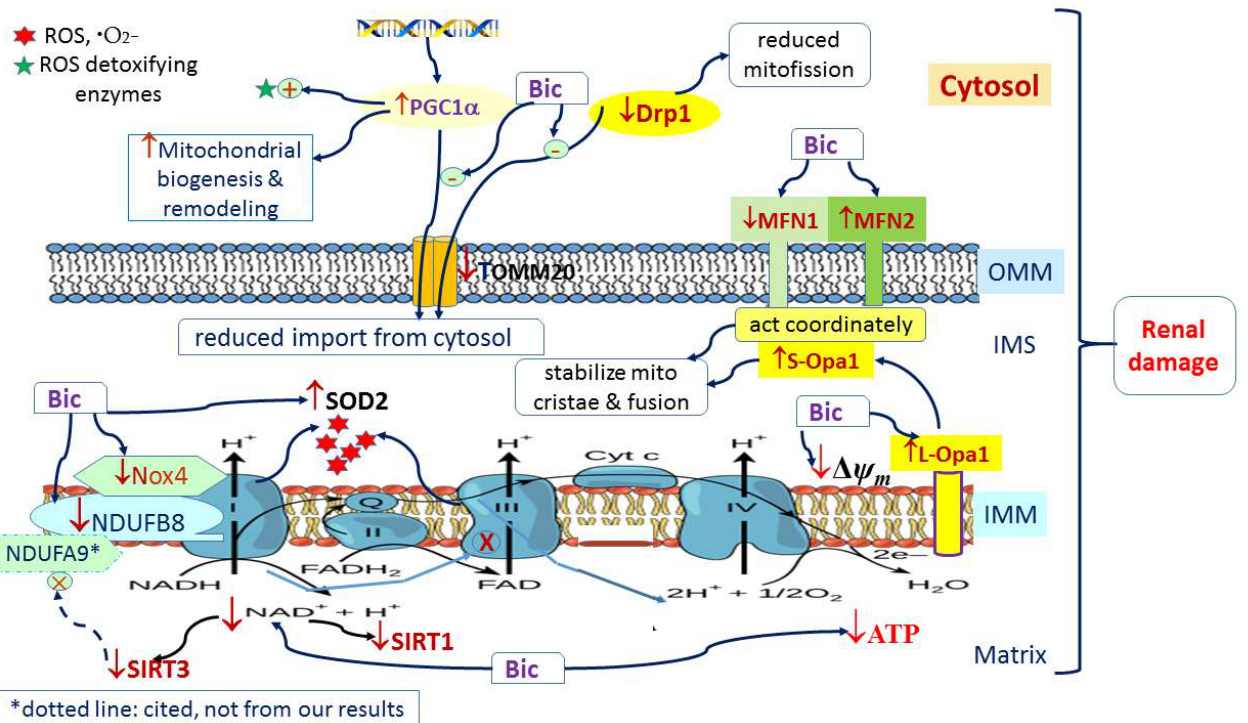
Figure 9. Graphic summary of mitochondria dynamics-related signaling pathways affected by bi- calutamide.